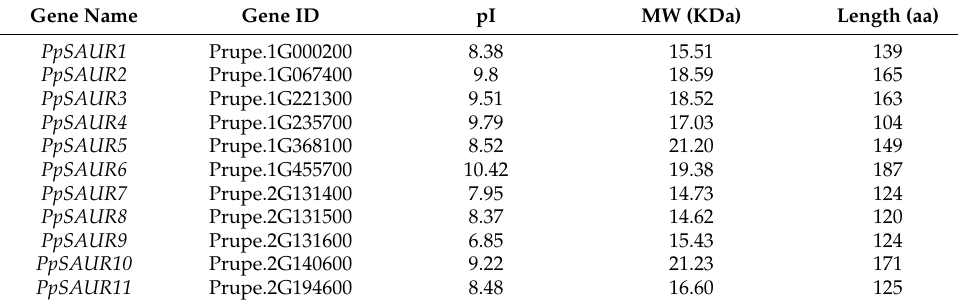
Table 1. Small auxin-up RNA (SAUR) gene family in